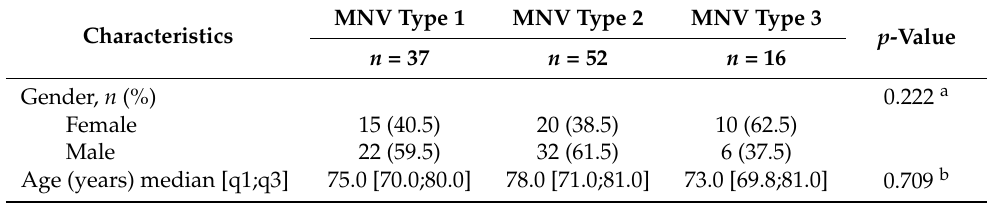
Table 1. Summary descriptive statistics by MNV groups for patients’ demographic characteristics.